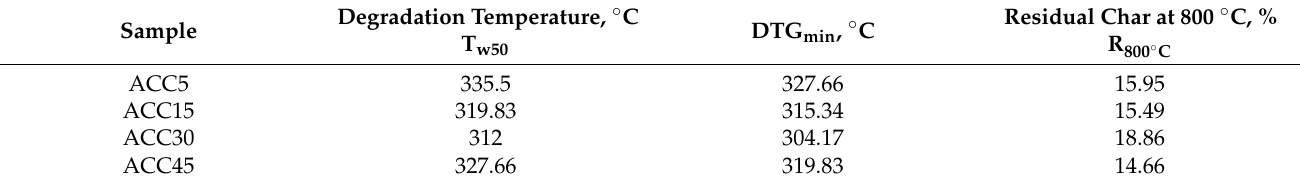
Table 5. Thermal properties of the ACC